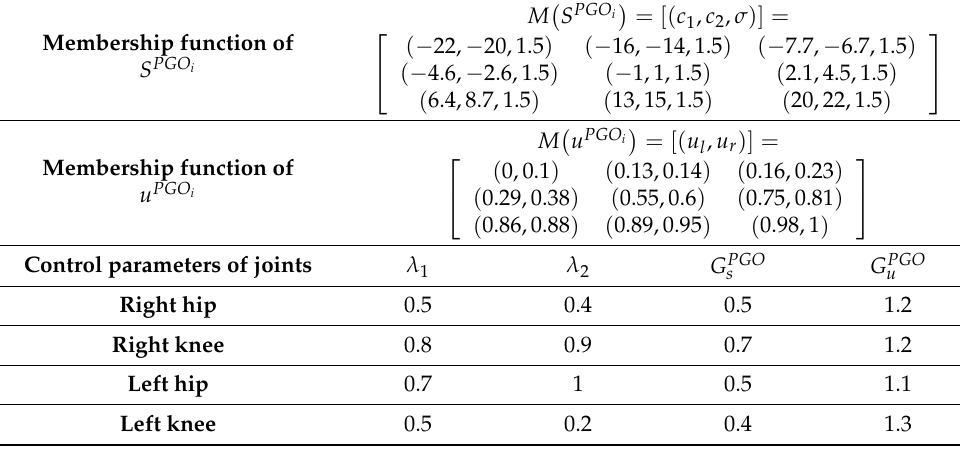
Figure 16. Tracking response of the interval type-2 fuzzy sliding pulse-width modulation controller on the right hip for the PGOS. ( a ) output response; ( b ) tracking error; ( c ) pulse-width modulation control signal. Table 3. Control parameters of the interval type-2 fuzzy sliding pulse-width modulation controller for the